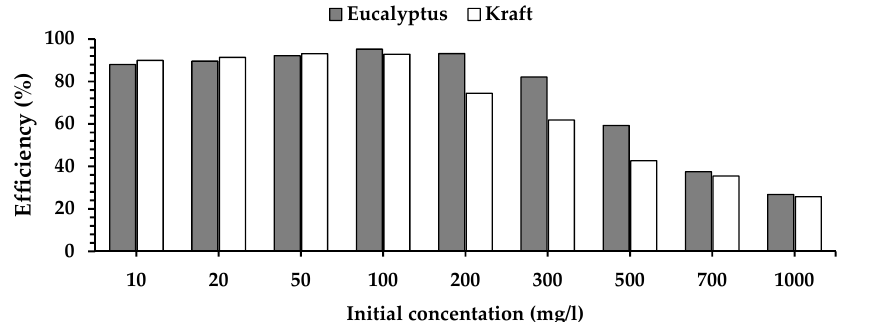
Figure 8. The efficiency of eucalypt stump lignin and kraft lignin in the removal of Cr(VI) at different initial concentrations.